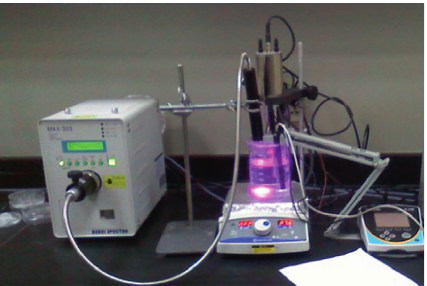
Figure 1: Experimental setup of UV treatment